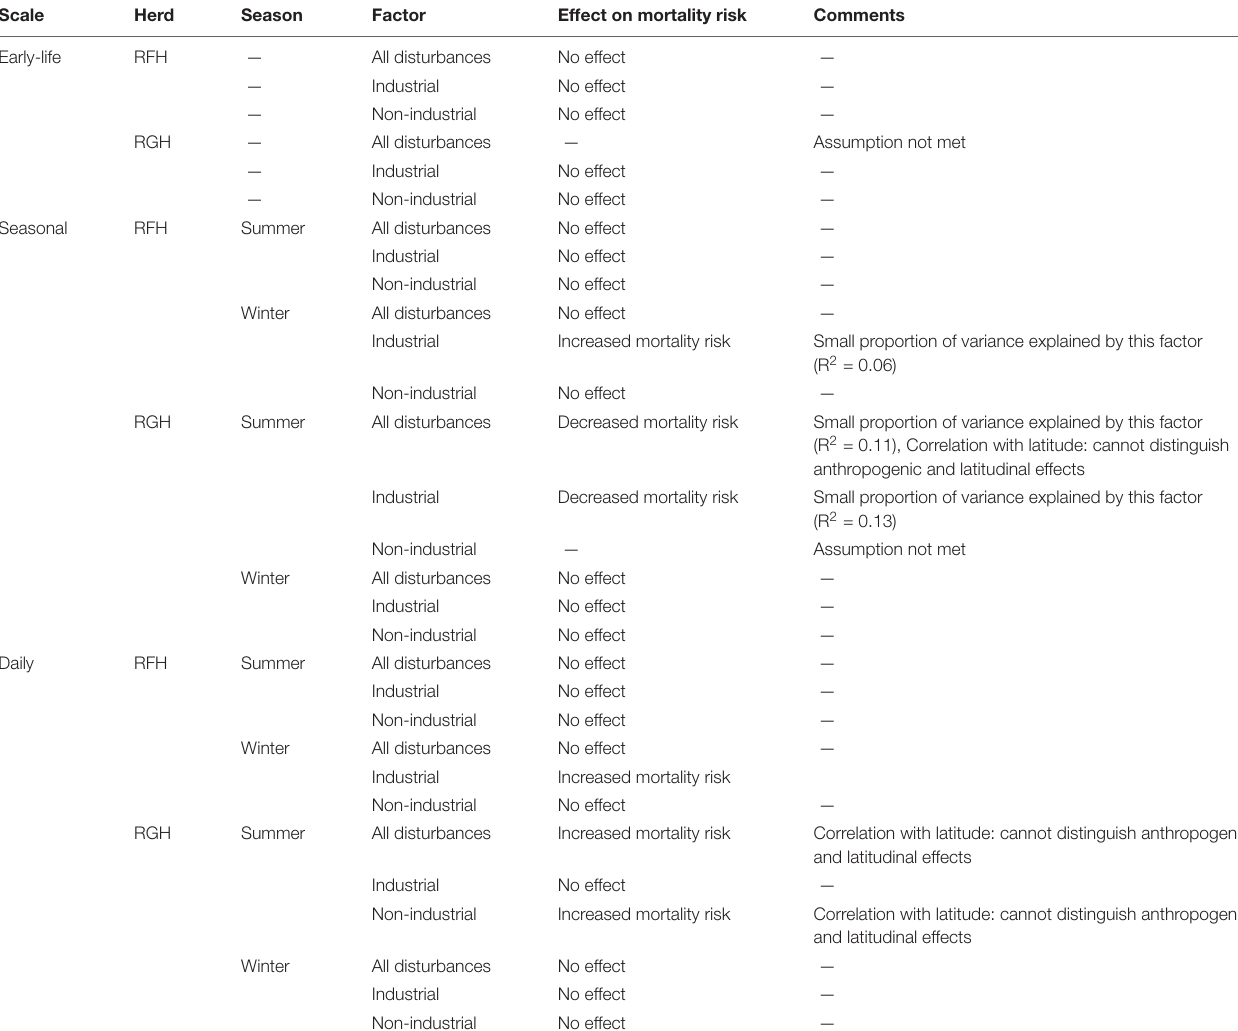
TABLE 3 | Summary of the effects of human disturbances (based on Cox-proportional hazard analyses) on early-life, seasonal and daily mortality risk of migratory caribou of the Rivière-aux-Feuilles (RFH) and Rivière-George herds (RGH), northern Québec and Labrador, Canada, 2009 − 2016. Scale Herd Season